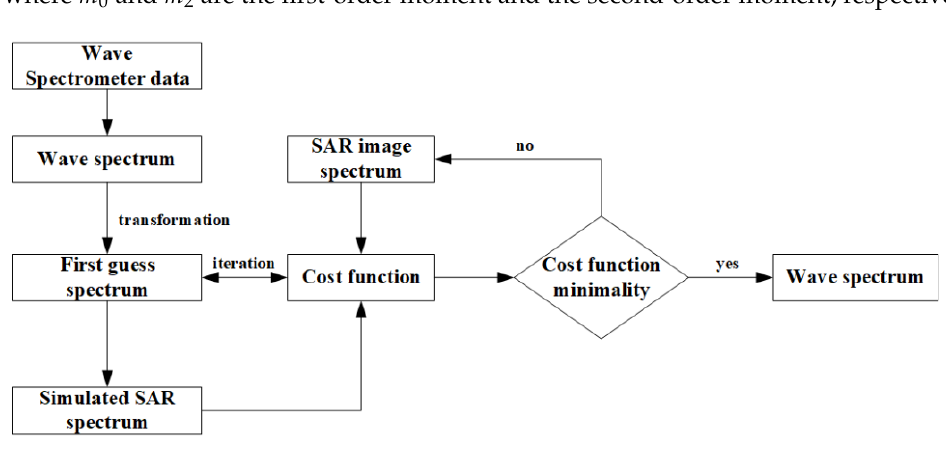
Figure 4. Flowchart of MPI method of different first-guess spectra.